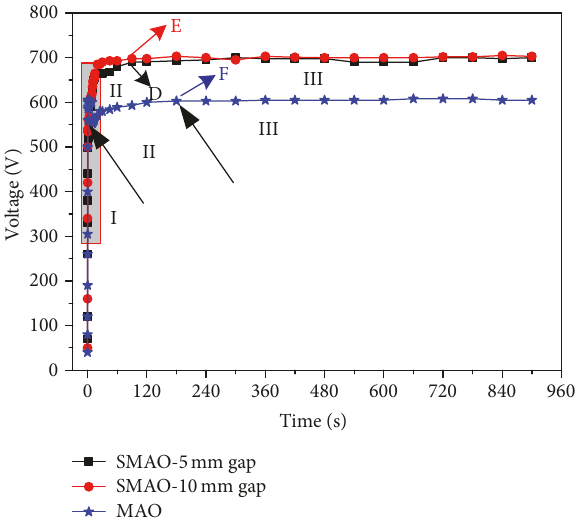
Figure 6: Long-term voltage-time response curves for SMAO (5mm and 10mm interelectrode gap and stationary anode) and MAO for A356 alloy.